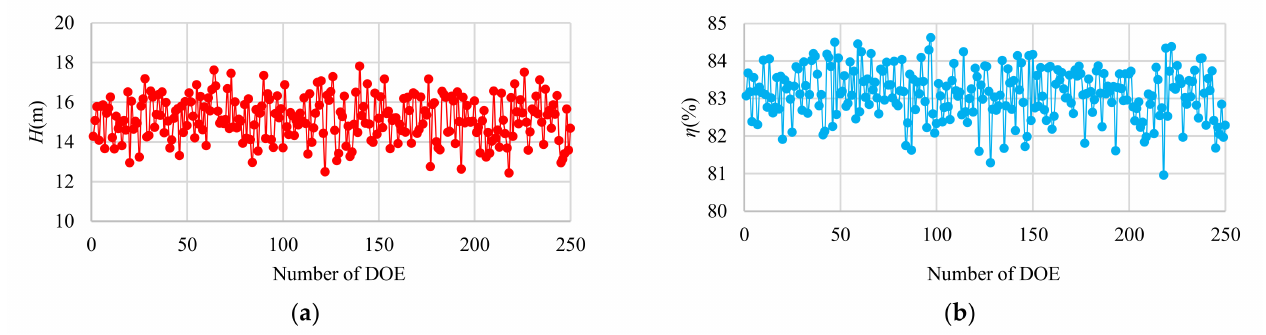
Figure 8. Results of DOE. ( a ) Head. ( b )